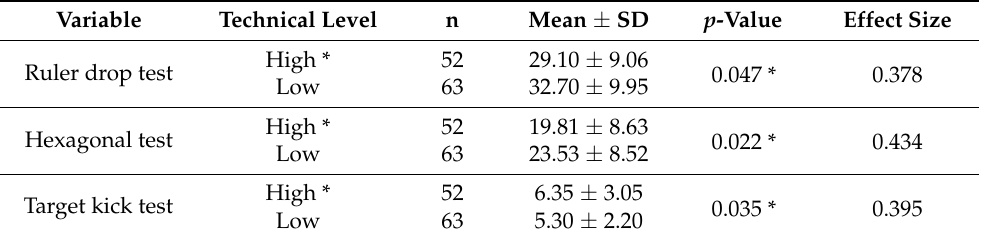
Table 4. Technical level differences in the motor coordination abilities (n = 115).